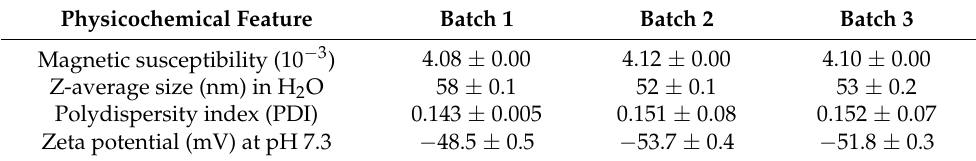
Table 1. Physicochemical characterization of